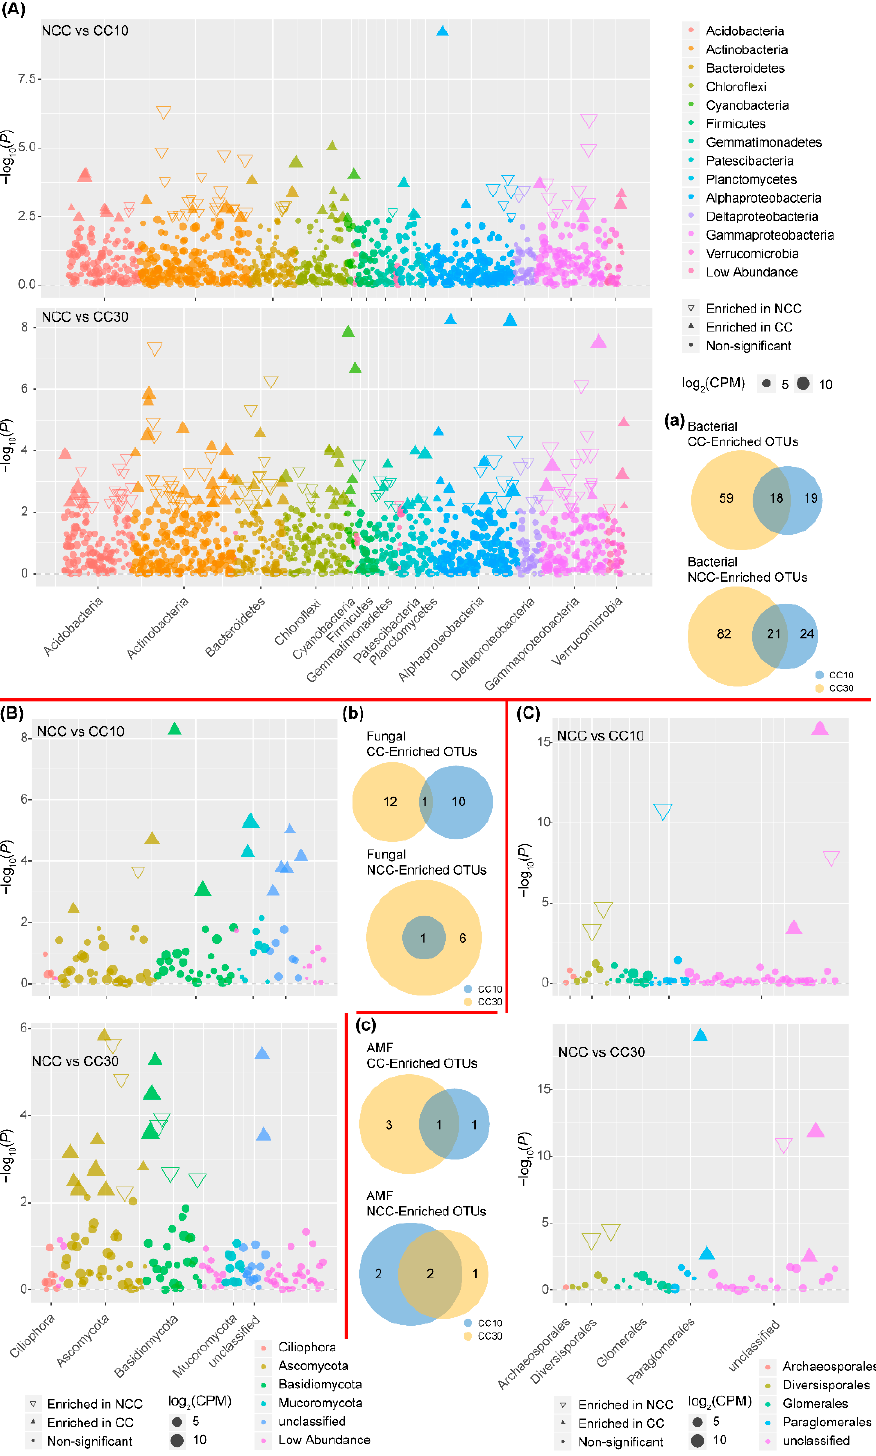
Figure 2. Taxonomic characteristics of differential bacteria ( A ), fungal ( B ) and AMF ( C ) between the “NCC” and “CC” groups microbiota. OTUs enriched in the “NCC” or “CC” groups are represented by filled or empty triangles, respectively (FDR adjusted p < 0.05, Wilcoxon rank sum test). OTUs are arranged in taxonomic order and colored according to the phylum or, for Proteobacteria, the class. CPM, counts per million. Among the three types of a, b, and c microorganisms, the overlapping part is rich or scarce in CC10 and CC30.